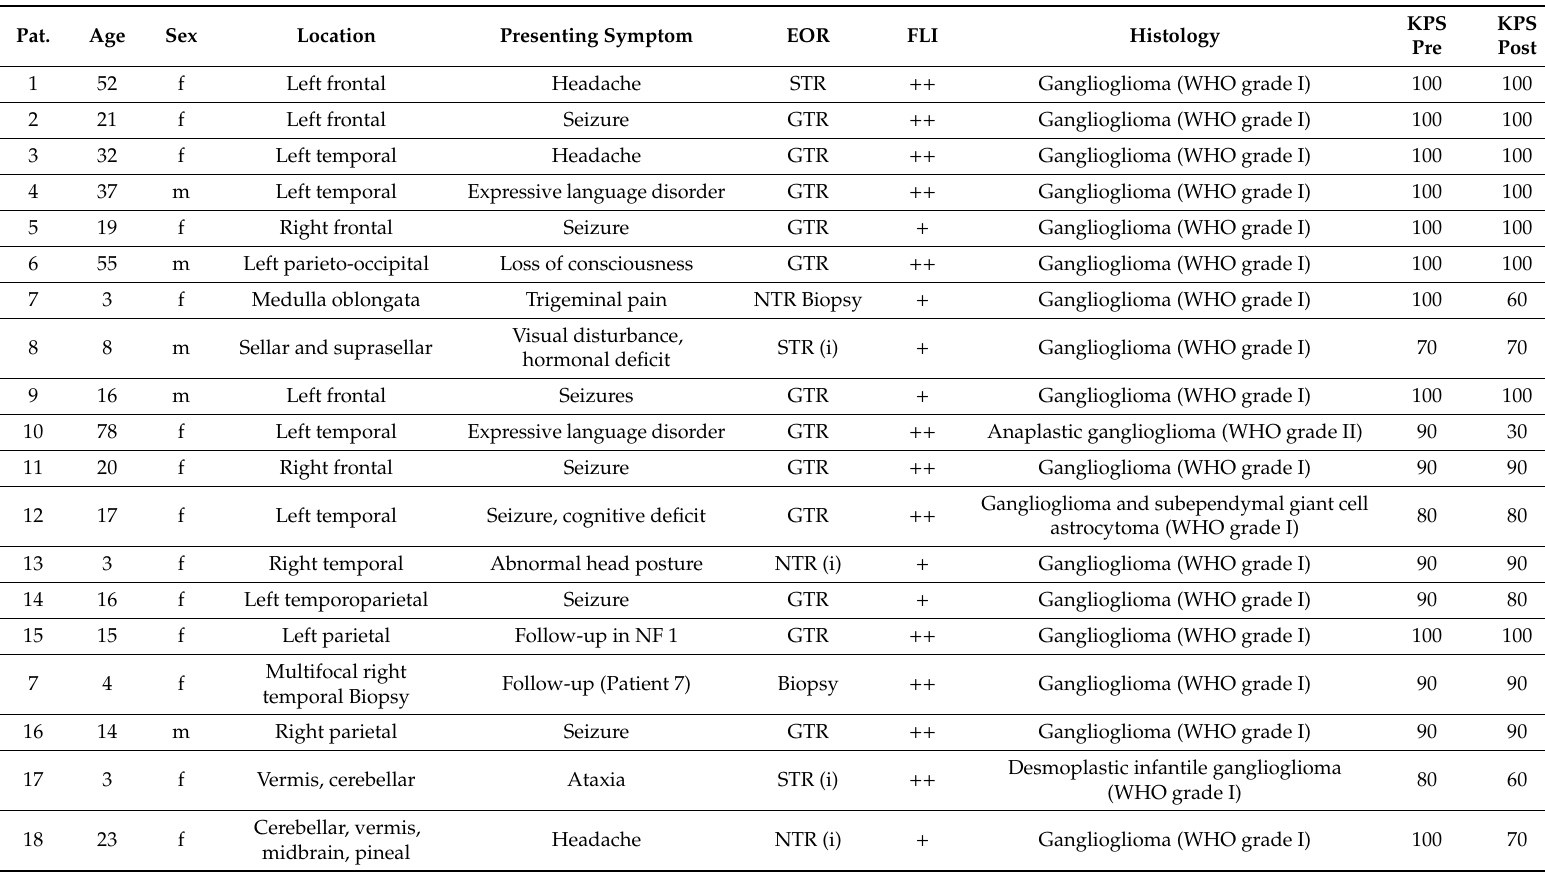
Table 1. Characteristics of the patients and main